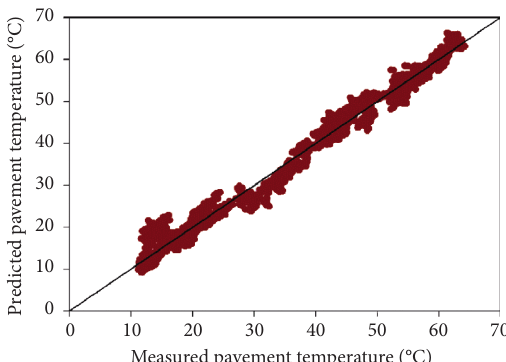
Figure 7: Measured versus predicted maximum temperature at 2cm depth [equation (2)] during 2014–2016.